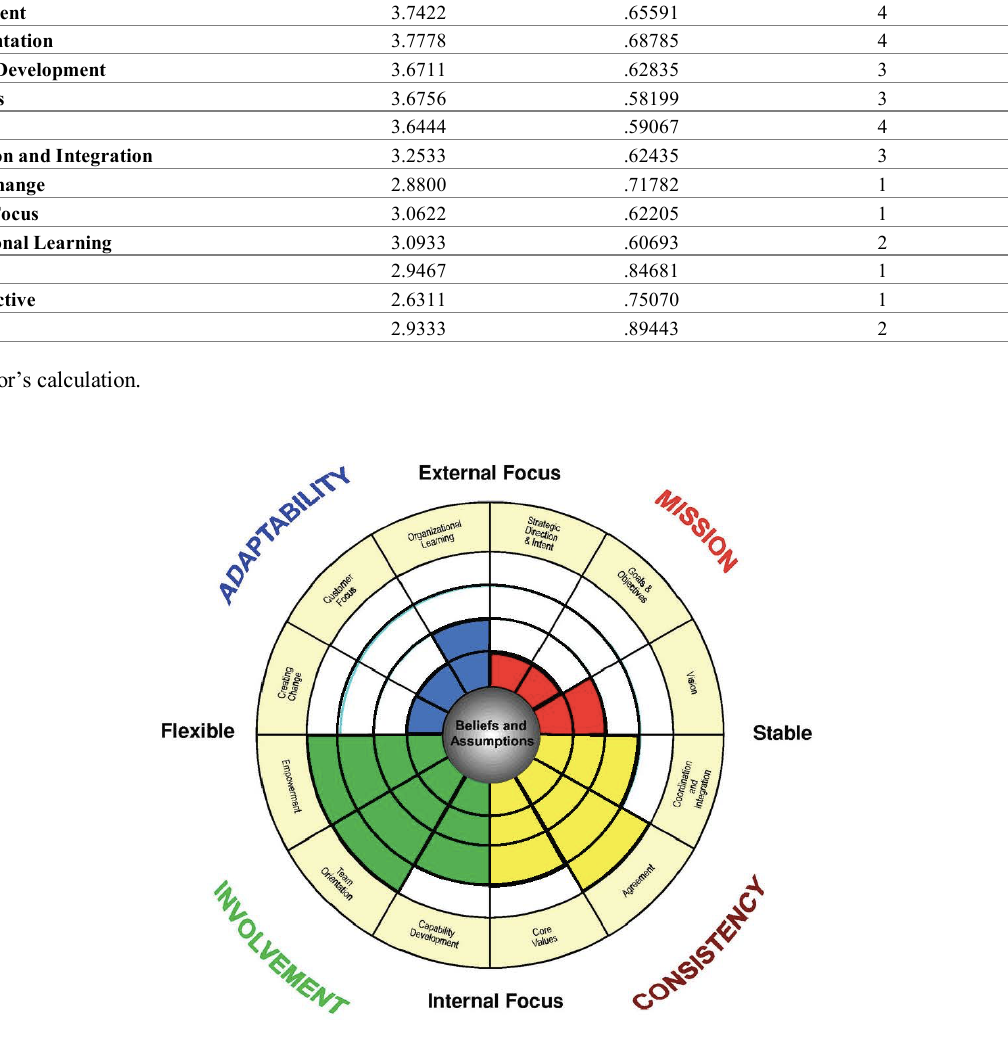
Figure 2: Denison’s Organizational Culture Dimensions indicating the culture profile of the Islamic Broadcasting